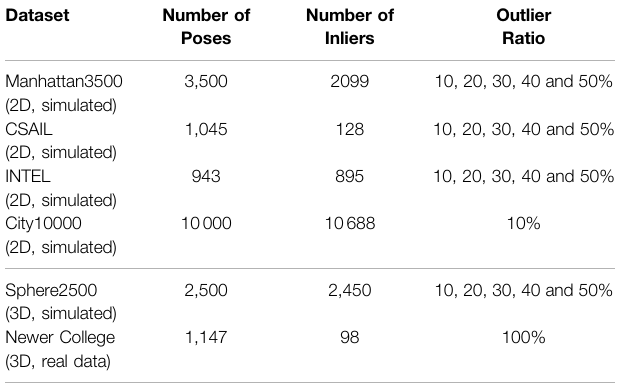
TABLE 1 | 2D and 3D datasets used in our experiments. Dataset